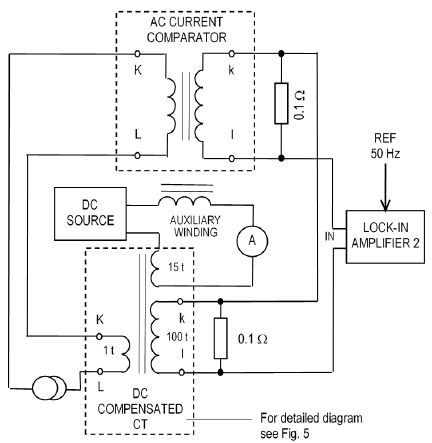
Figure 8. Measurement setup for testing the accuracy of the DC-compensated CT using a lock-in amplifier.